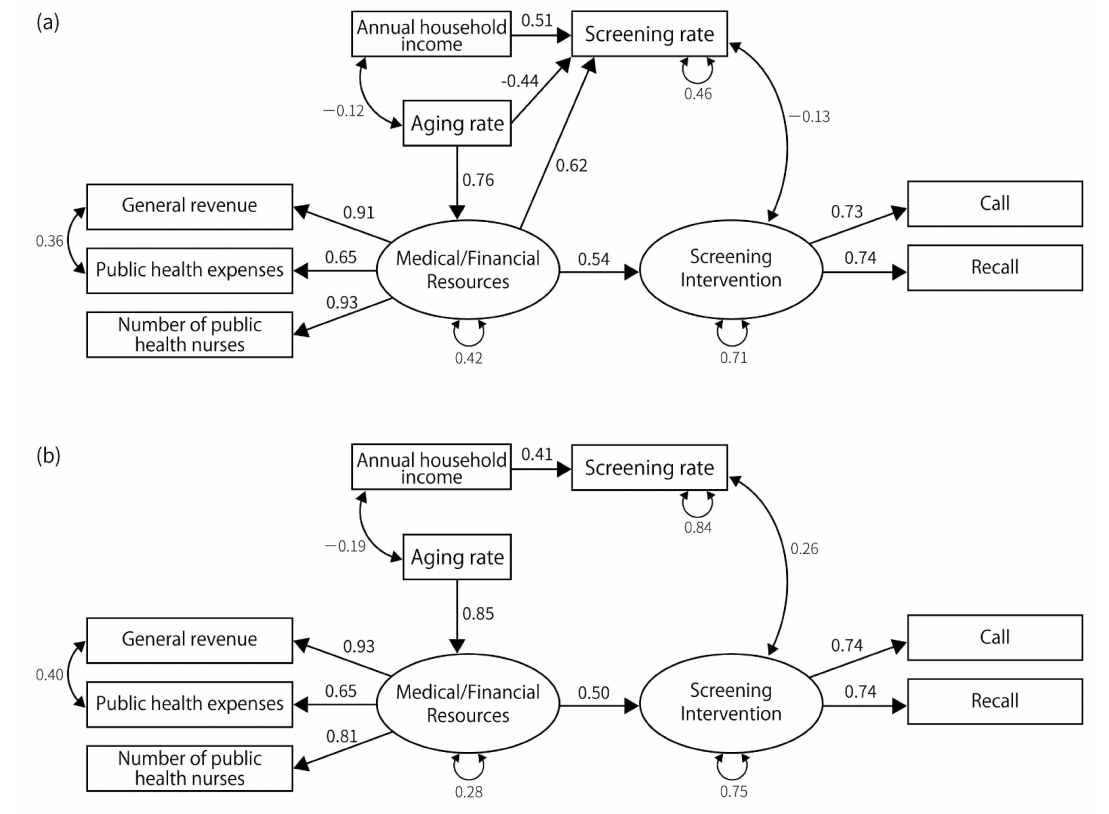
Figure 6. The final model for colorectal cancer. ( a ) The final model for colorectal cancer screening in males. GFI = 0.874, AGFI = 0.717, PGFI = 0.388, SRMR = 0.108, CFI = 0.911, RMSEA = 0.133, p -value by χ 2 test = 0.022, χ 2 = 29.362, degrees of freedom = 16. ( b ) The final model for colorectal cancer screening in females. GFI = 0.876, AGFI = 0.753, PGFI = 0.438, SRMR = 0.110, CFI = 0.898, RMSEA = 0.142, p -value by χ 2 test = 0.009, χ 2 = 35.111, degrees of freedom =